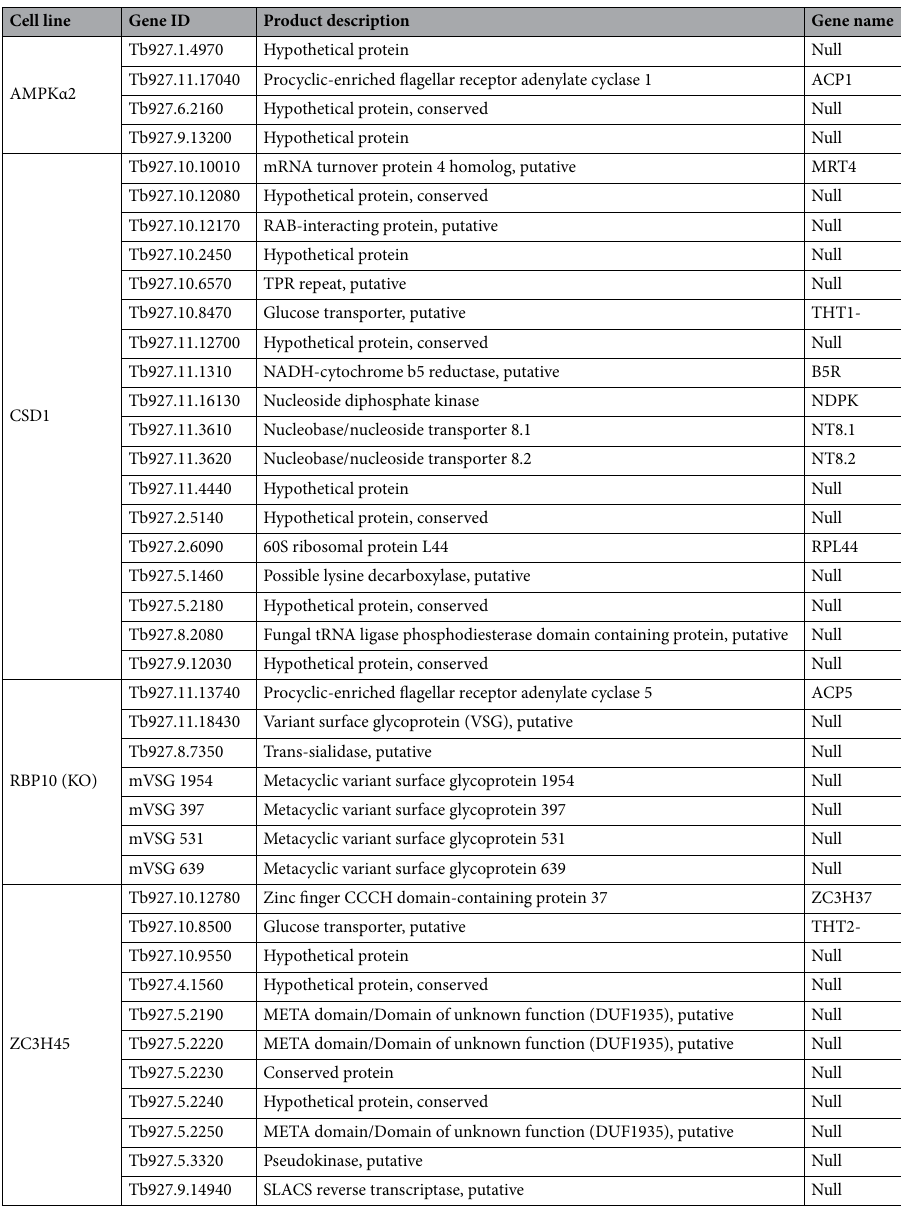
Table 2. Uniquely downregulated transcripts in individual RNAi and KO cell